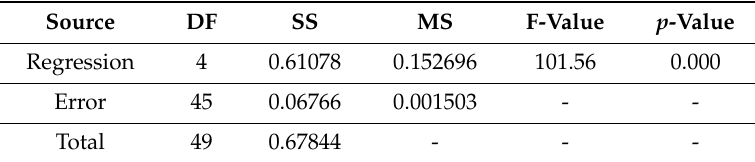
Table 9. Variance for PAT η at 1.0 Q d.